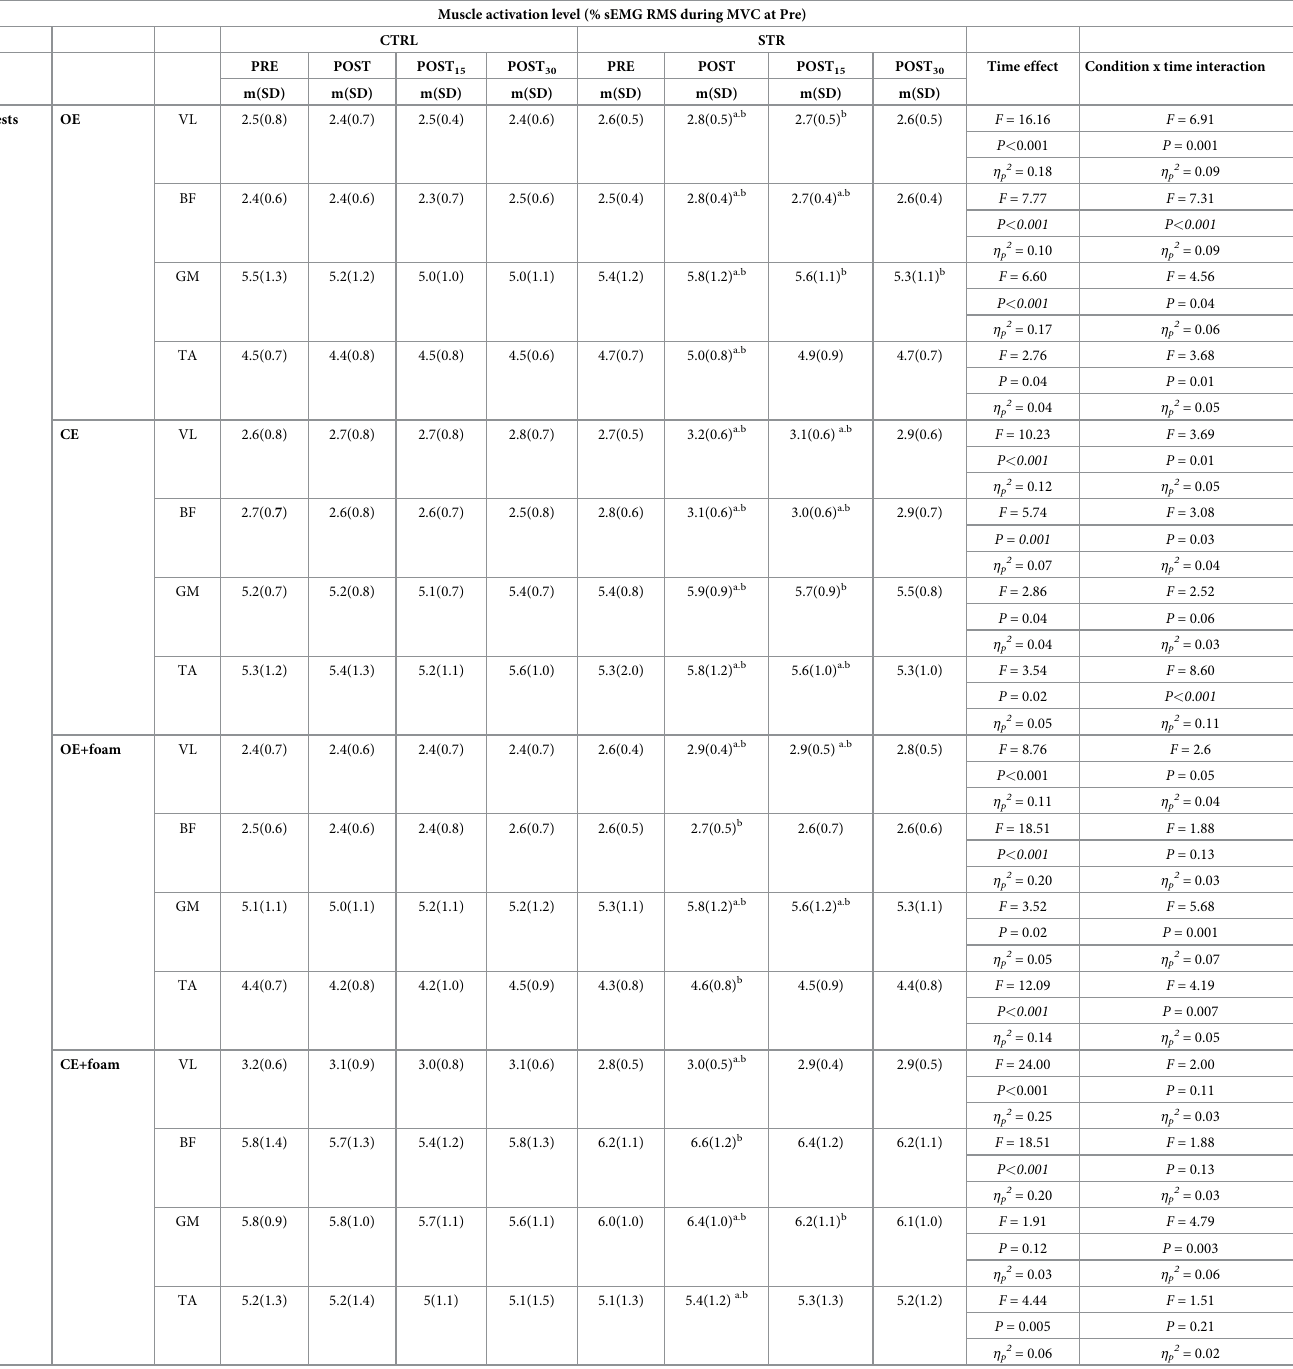
Table 6. Percentage of muscle activation time course in the control (CTRL) and stretching session (STR) during the static